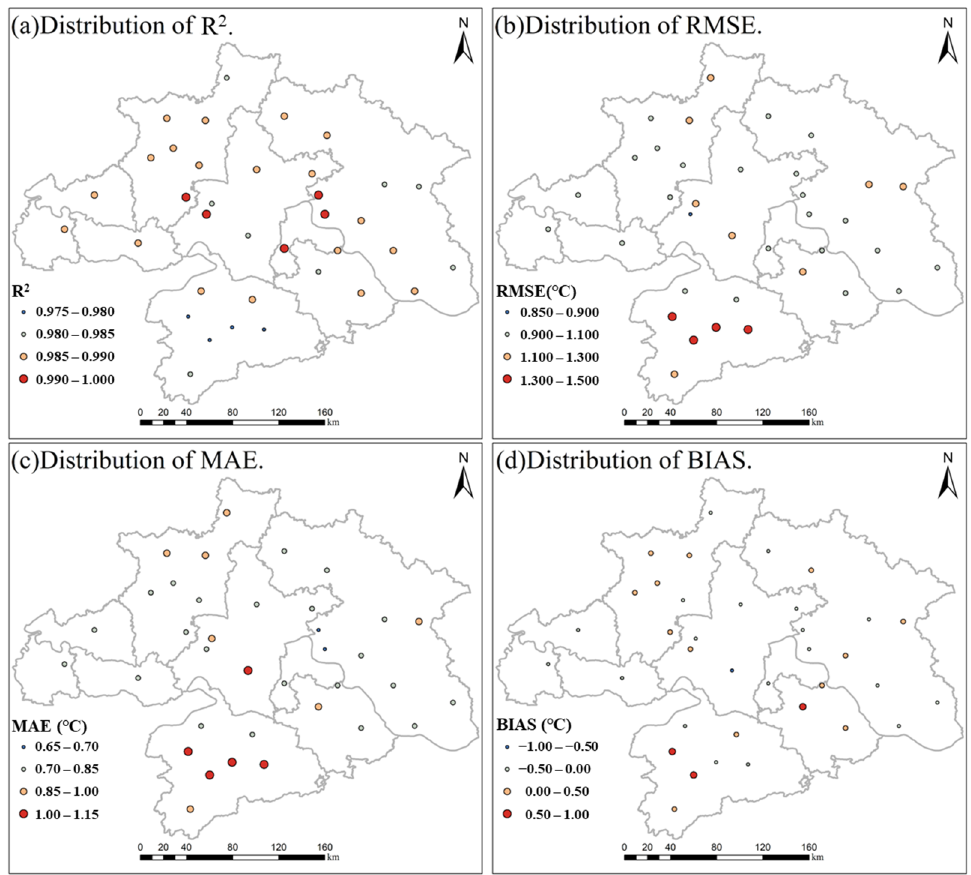
Figure 7. The spatial distribution of statistical metrics all sites in WMA. ( a – d ) represent the distri- bution of R 2 , RMSE, MAE and BIAS.